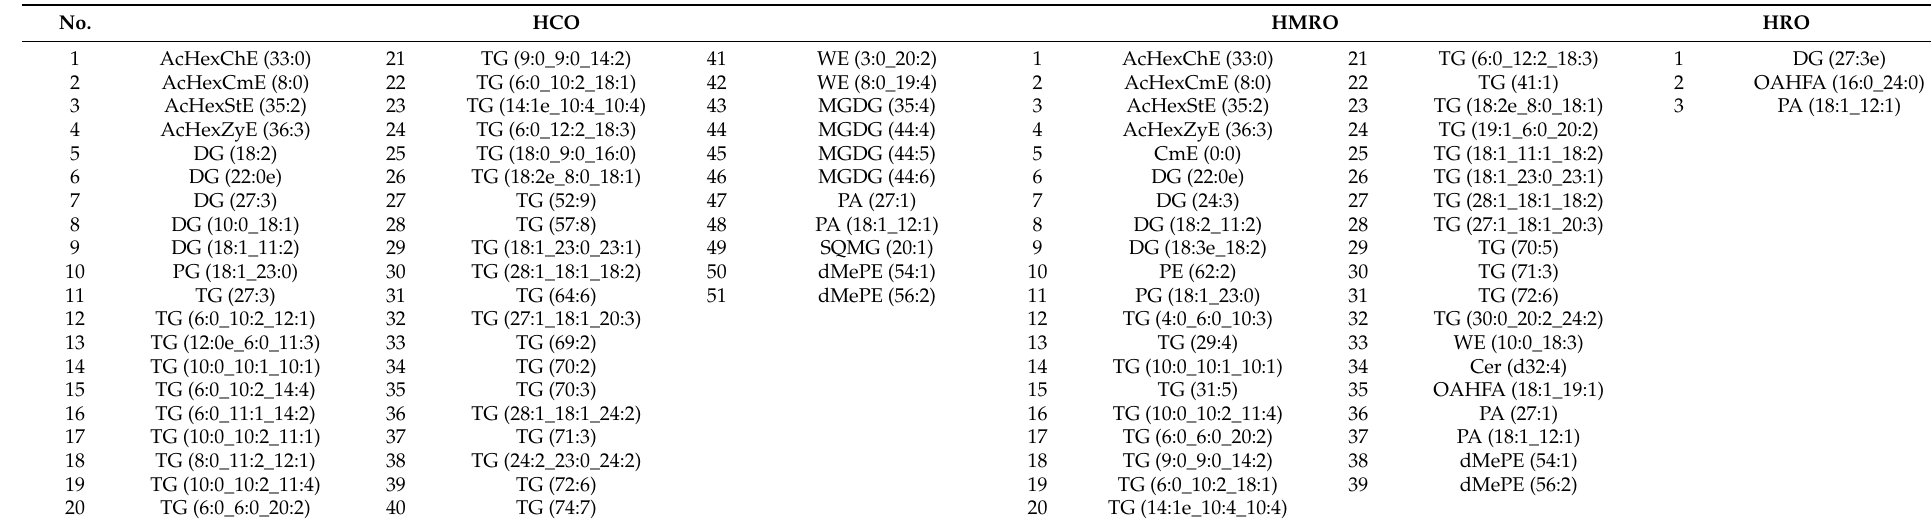
Table 3. New lipids appeared after the heating process in three kinds of camellia